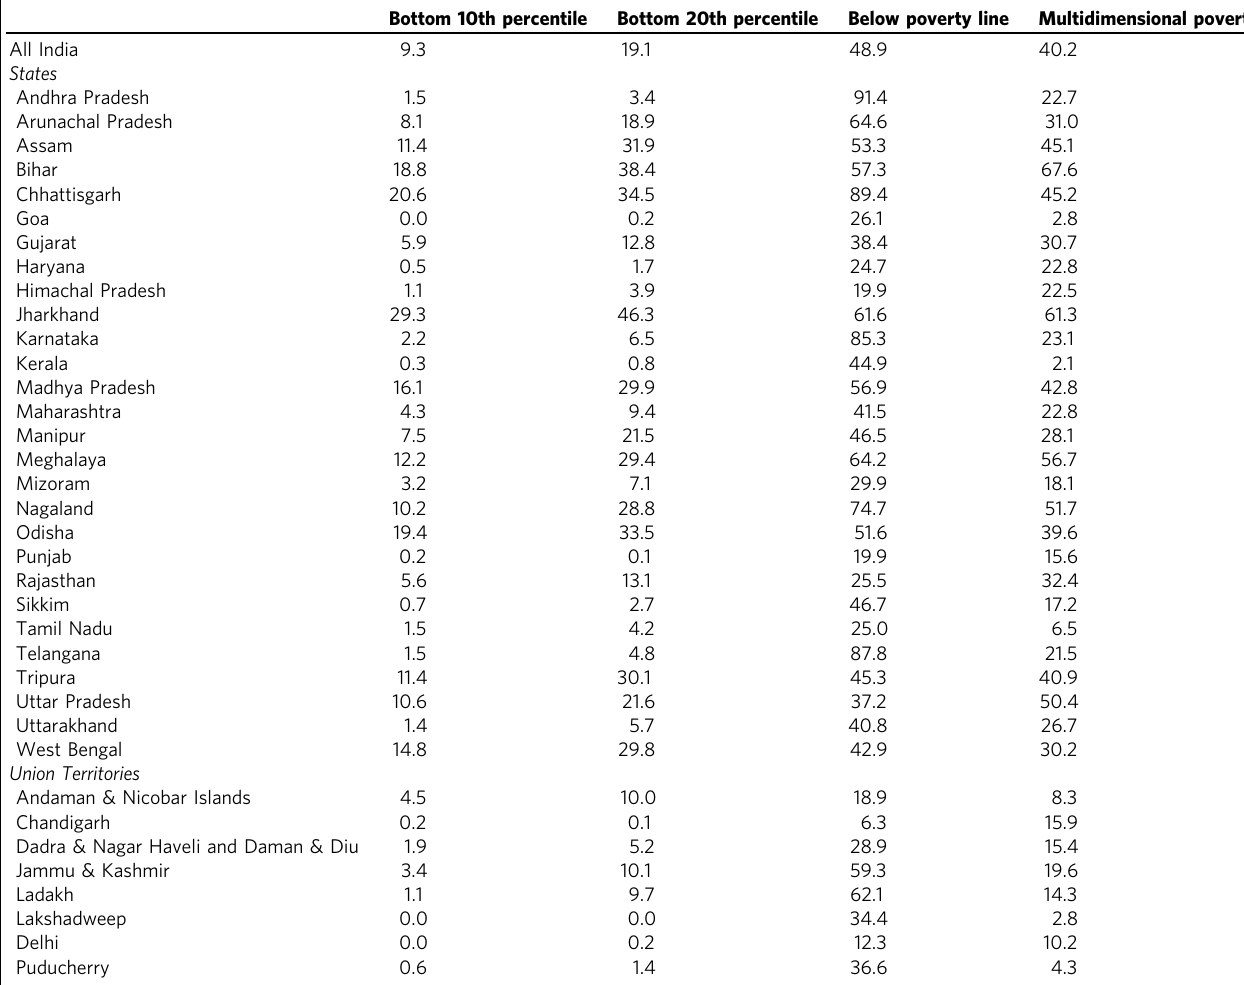
Table 1 Percent prevalence of four measures of poverty in 2021 across states and Union Territories in India. Bottom 10th percentile Bottom 20th percentile Below poverty